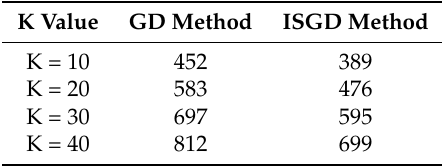
Table 3. Computation time comparison